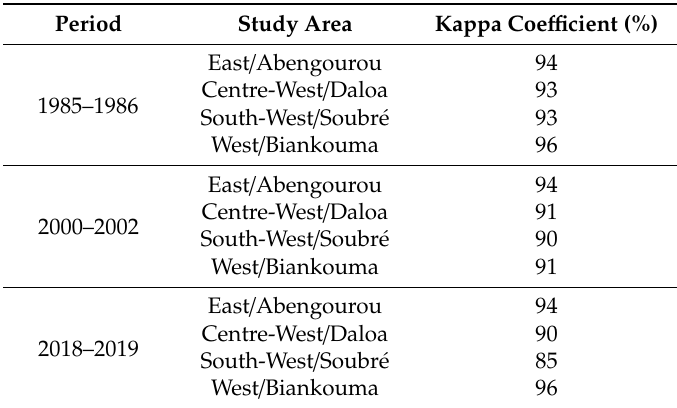
Table 2. Kappa coe ffi cients of classified